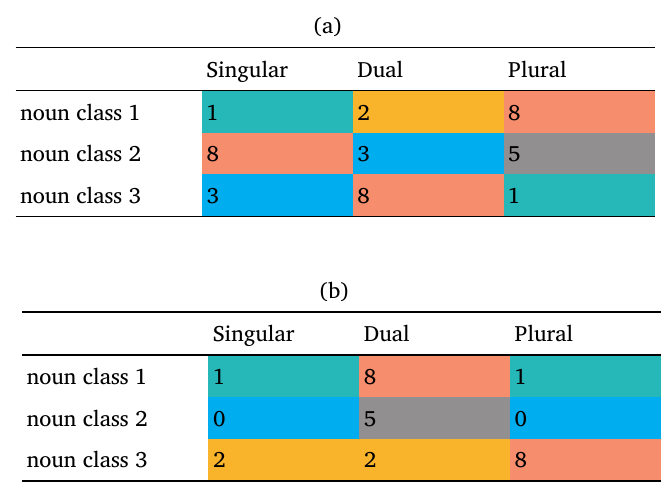
Table 6: Two example paradigms (with affixes indicated by integers) differing only in their degree of cross-class syncretism: (a) shows only across-class syn- cretism, while (b) shows mostly within-class syncretism. For both paradigms i- complexity (0 bits), e-complexity (1.58 bits) and number of markers (5 markers) are matched. Paradigm (b) is learned more accurately by our